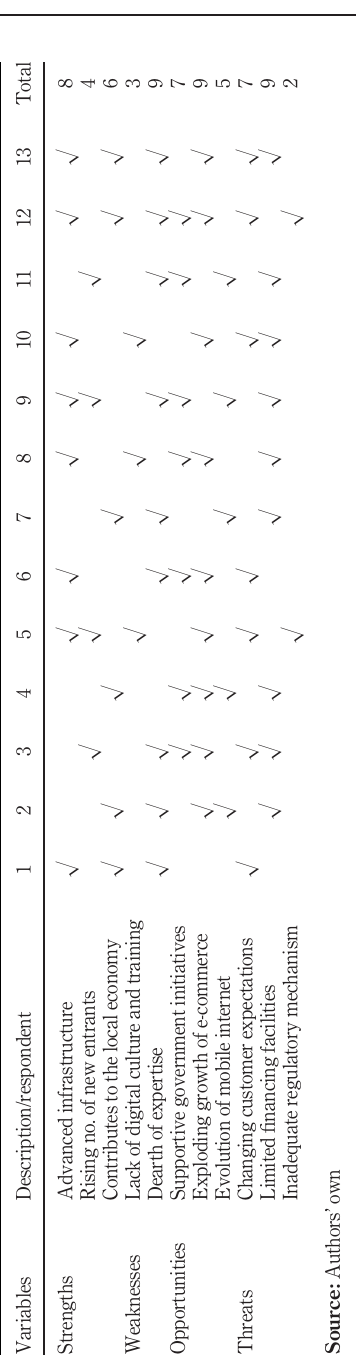
Table 3. Content